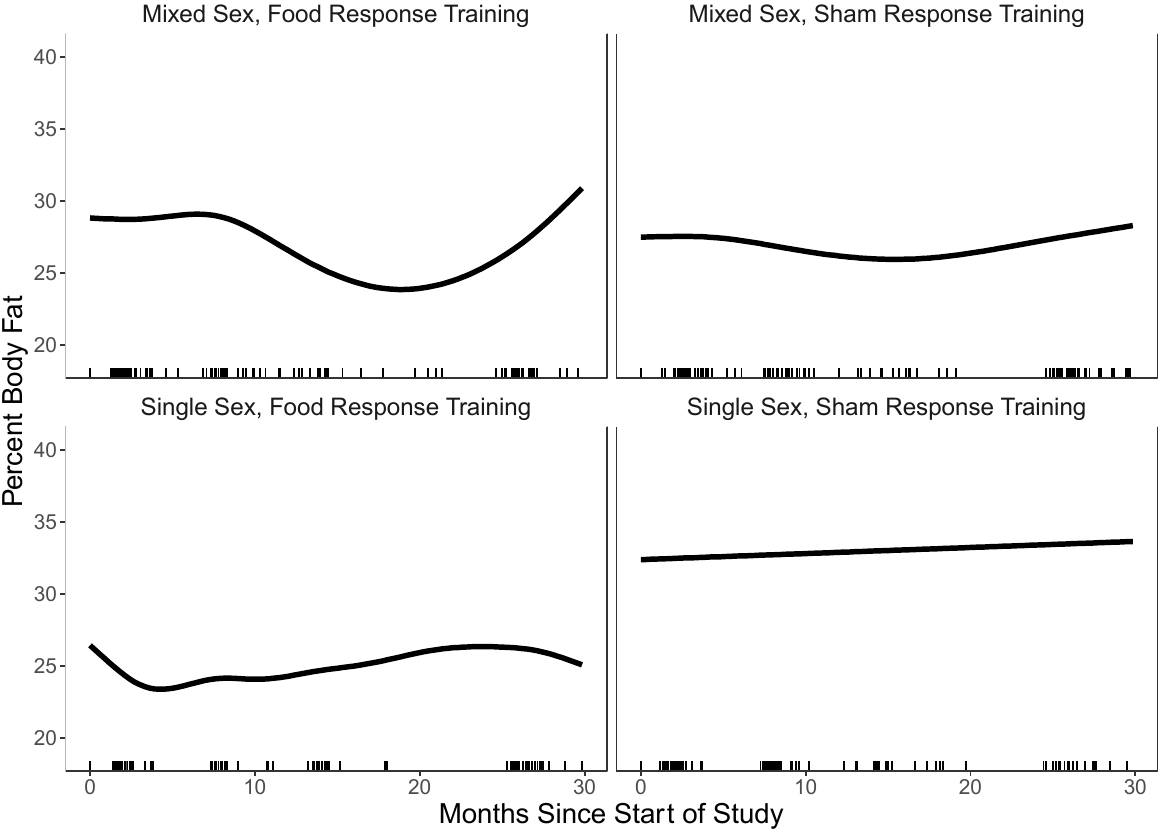
Figure 2. All panels present change in percent body fat over the 2-year follow-up in each of the four conditions. Model Predicted Change in Percent Body Fat by Condition.